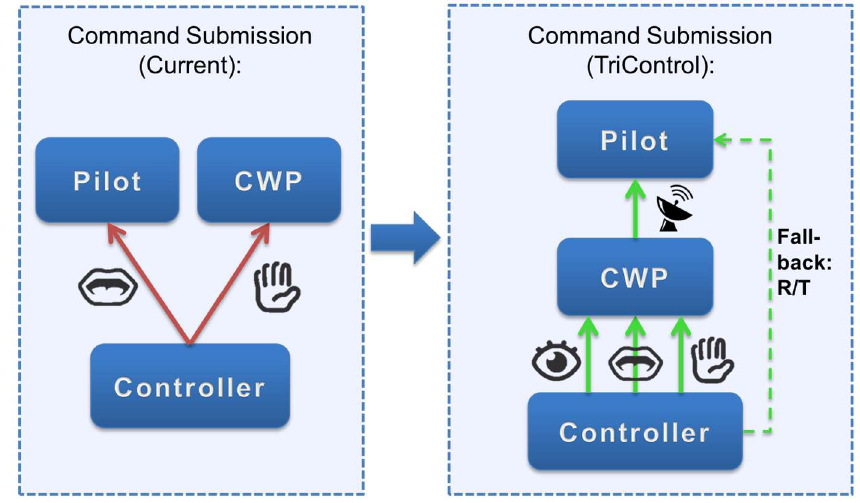
Figure 1. Difference between current controller command submission and TriControl command submission.